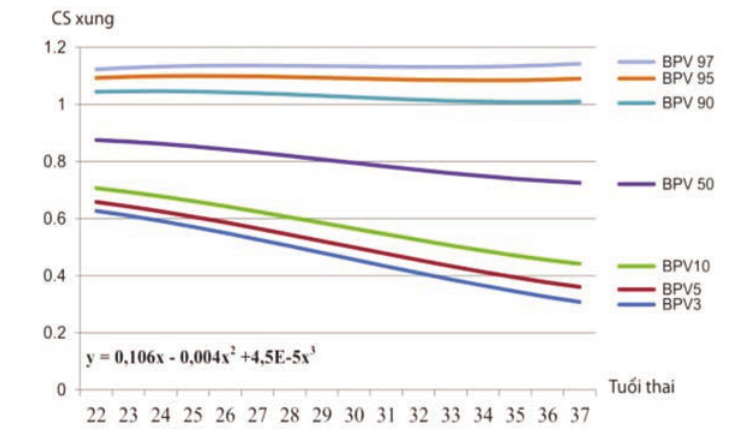
Figure 3. DVPI centile diagram for gestational age 22-37 weeks.